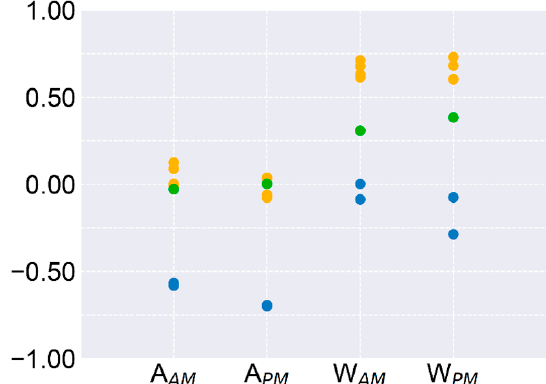
Figure 6. Pearson R correlation between normalized polarization ratio and in situ 0–5 cm temperature time series for an annual (‘A’, full year) and winter (‘W’, October–March) temporal subset. Blue, yellow, and green points represent Idaho, Iowa, and Indiana grids, respectively.